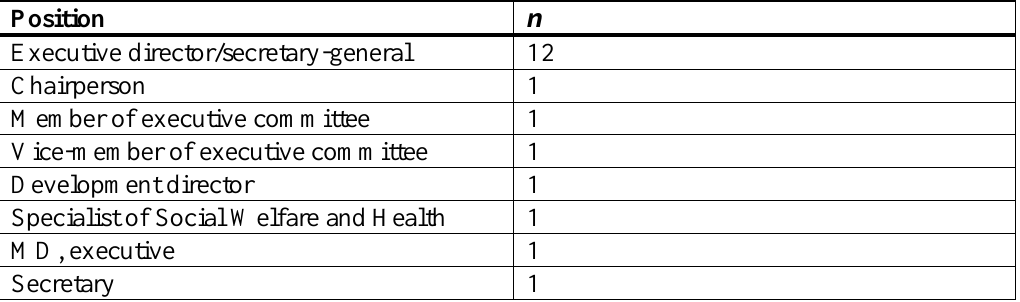
Table 4. The organizational positions of the